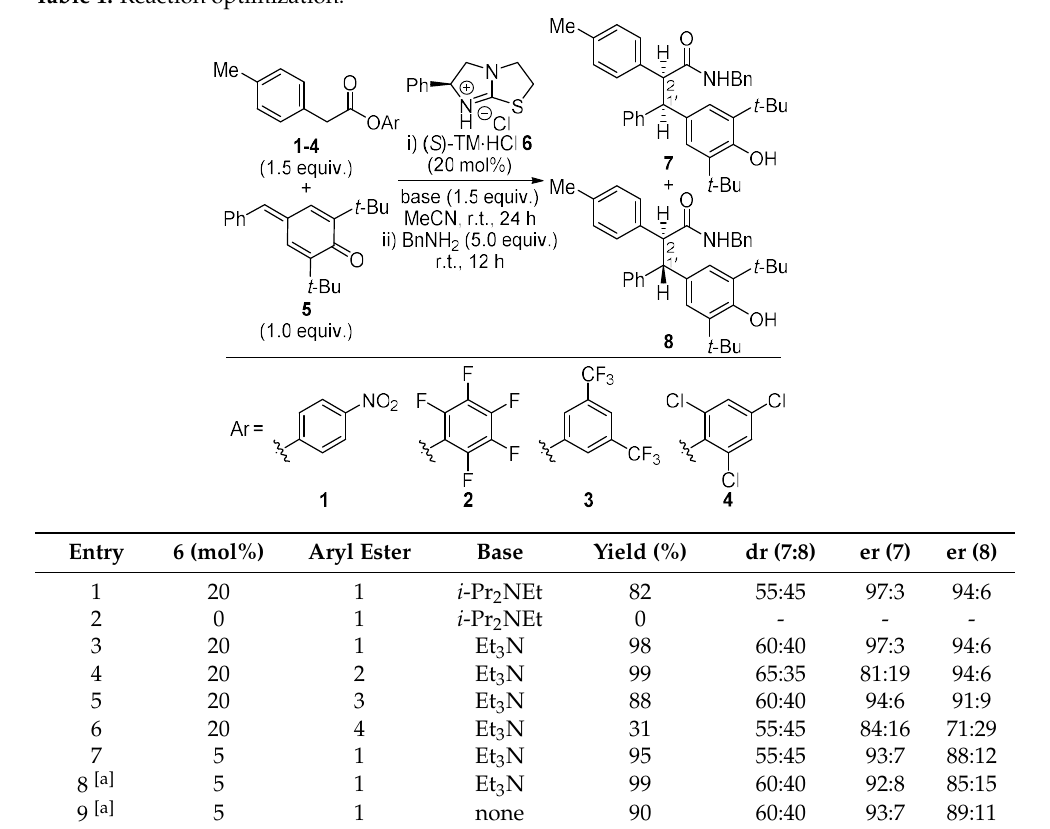
Table 1. Reaction Table 1. Reaction optimization.